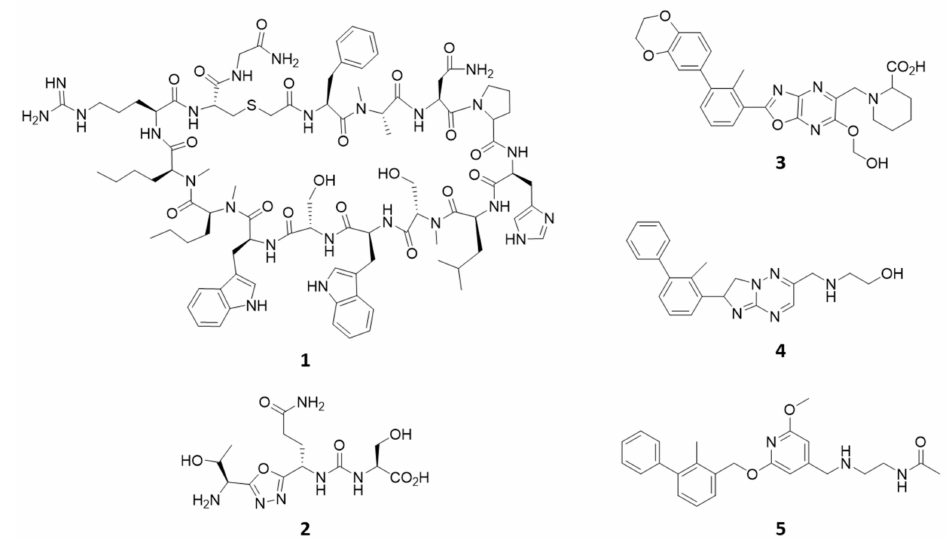
Figure 1. Examples of chemical structures of cyclic peptides ( 1 ), peptidomimetics ( 2 ), and biphenyl derivatives ( 3 – 5 ) reported as PD-1/PD-L1